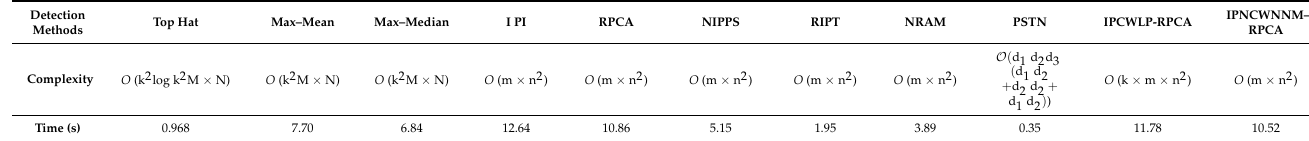
Table 5. Comparative analysis of the costs and time involved in the